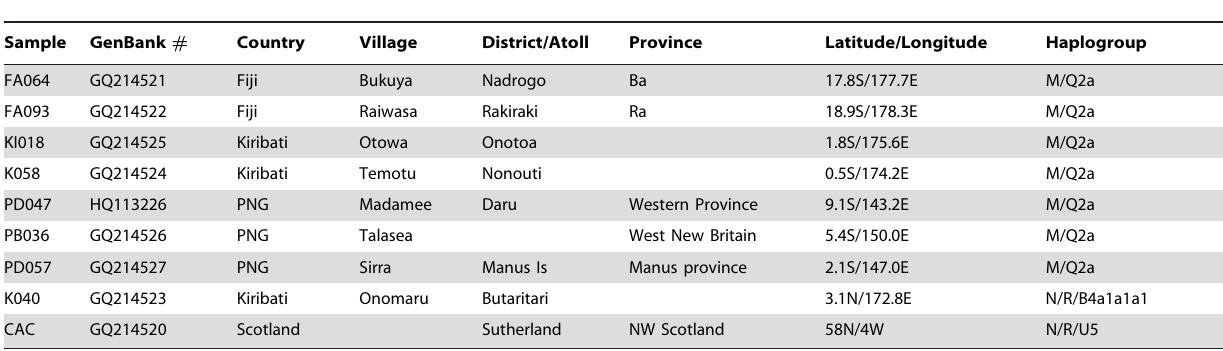
Table 1. Locations for ancestral maternal lineages.